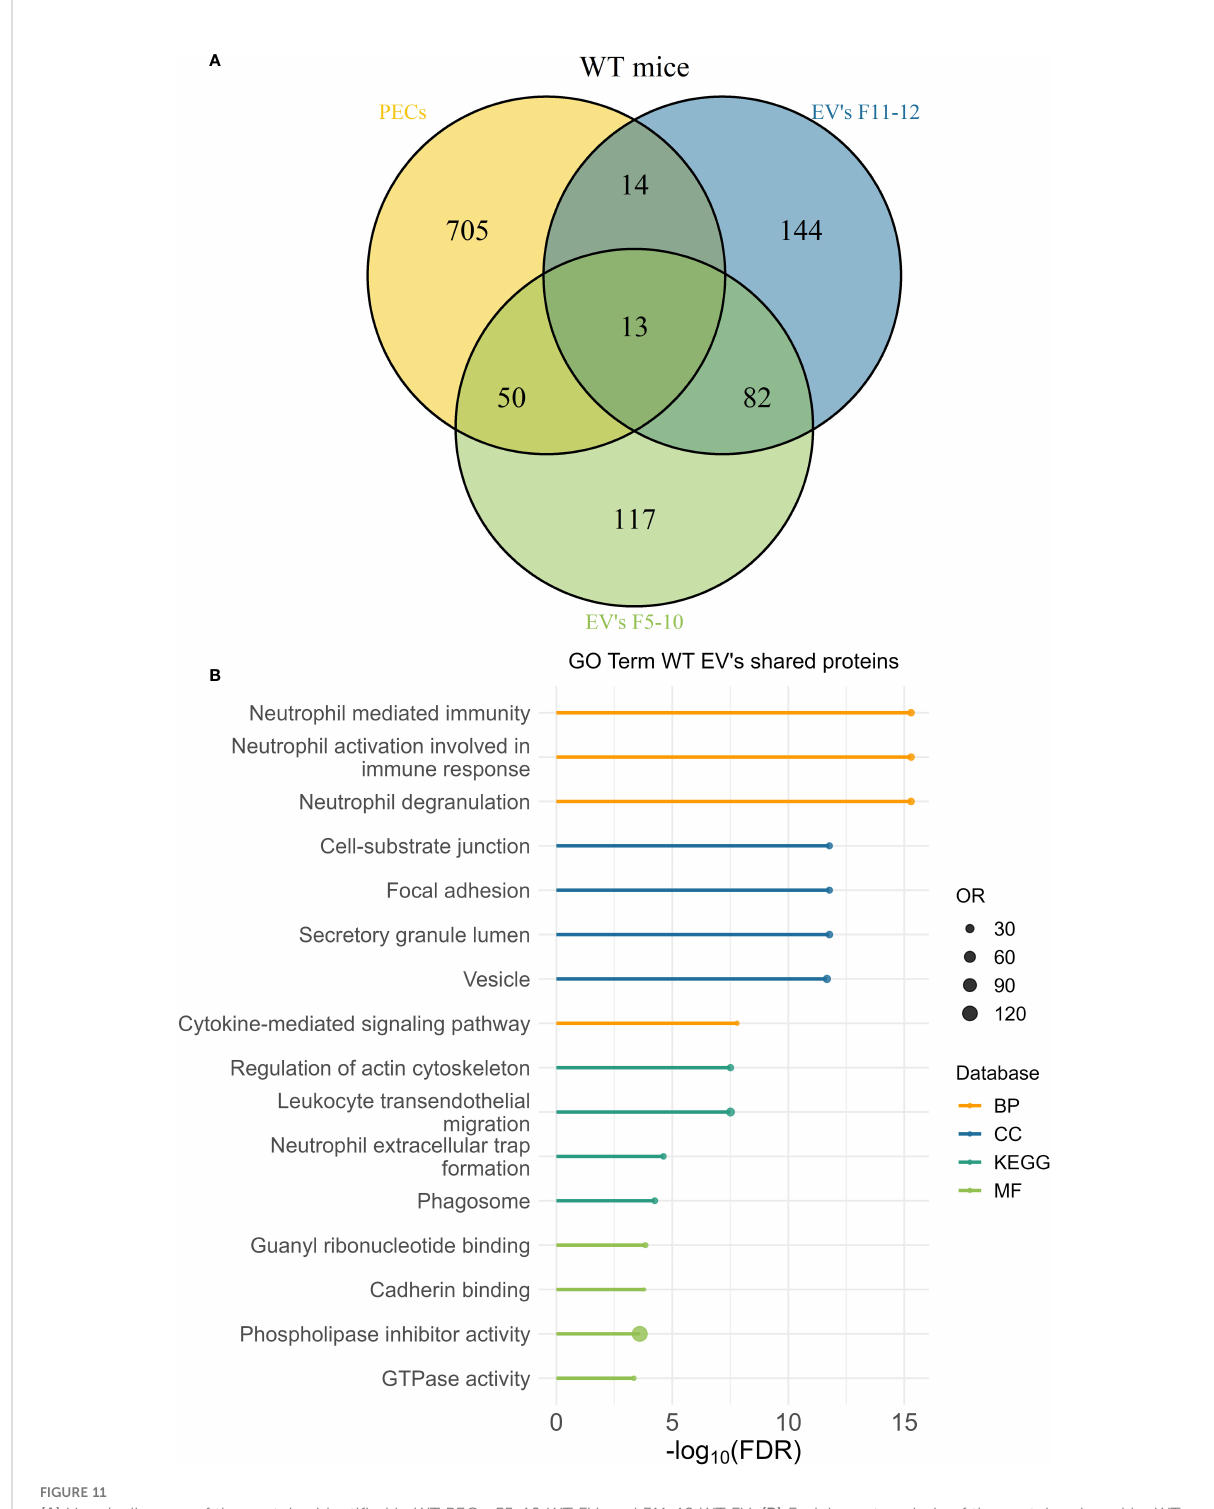
FIGURE 11 (A) Venn ’ s diagram of the proteins identi fi ed in WT PECs, F5-10 WT EV, and F11-12 WT EV. (B) Enrichment analysis of the proteins shared by WT PECs with F5-10 and F11-12 WT EV. The EnrichR software was used as described in Material and Methods. The – log 10 (FDR) was calculated for each database (KEGG, Biological Process, Molecular Function and Cellular Component) and the top 4 terms per each database was selected to display in the